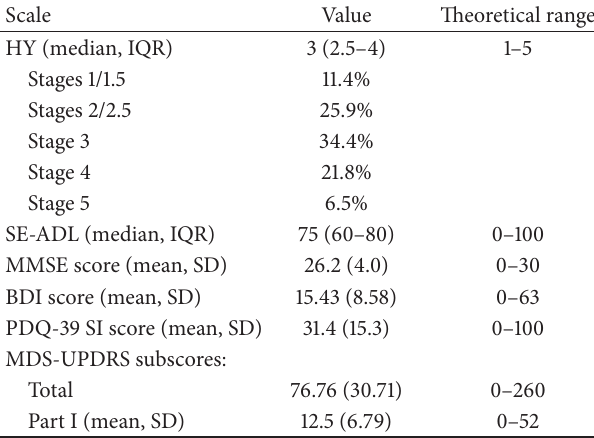
Table 1: Descriptive characteristics of clinimetric scales.